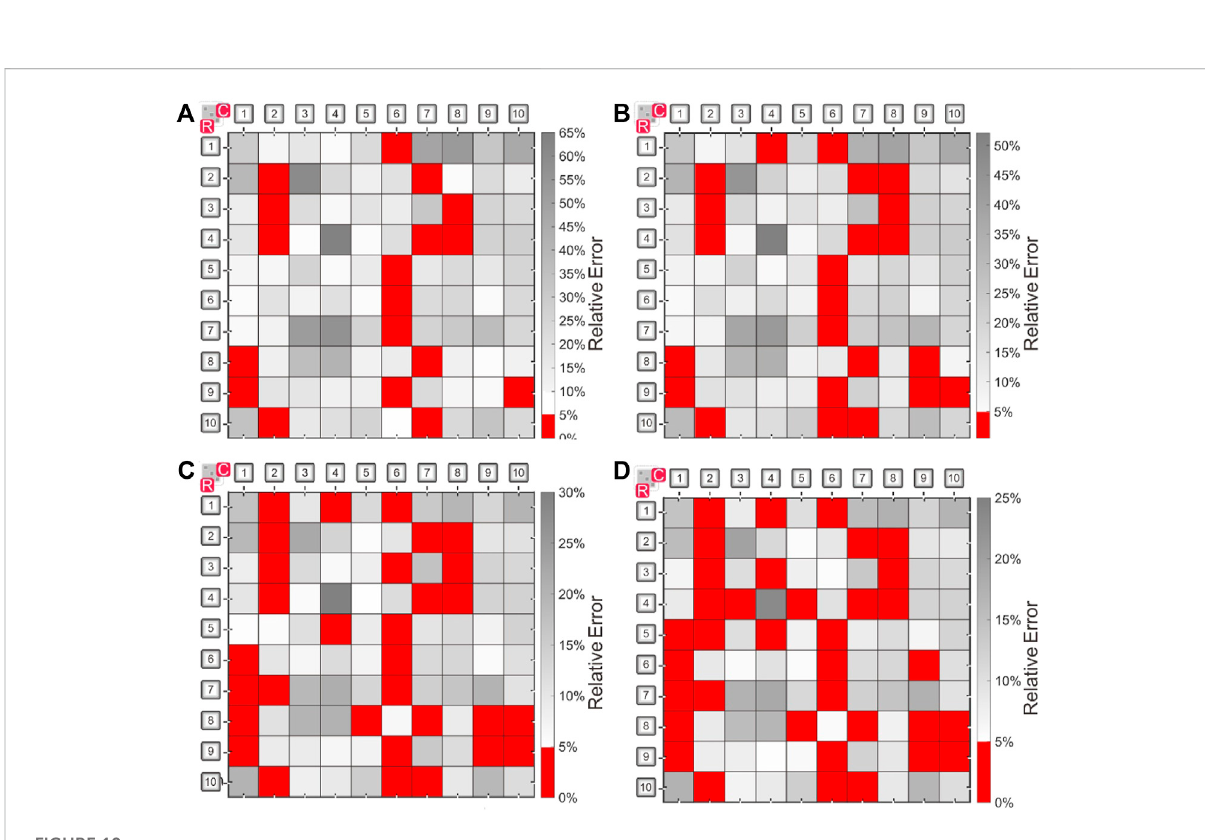
FIGURE 10 The locations of representative specimens determined under different normal stresses. (A) σ n = 0.2 MPa; (B) σ n = 1.0 MPa; (C) σ n = 5.0 MPa; (D) σ n = 10.0